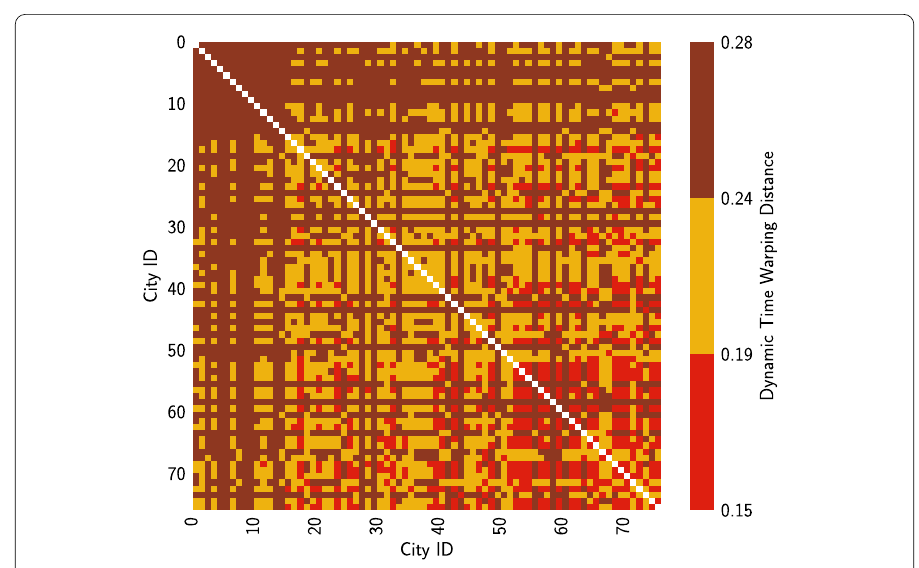
Figure 2 Heatmap for dynamic time warping distance. Each cell of this heatmap represents the mean value over weekdays of the DTW distance between two cities. In the x and y axes the cities are sorted by volume of calls from lower (top left corner) to higher (bottom right corner). Blanks in the diagonal represent the DTW distance between each city and